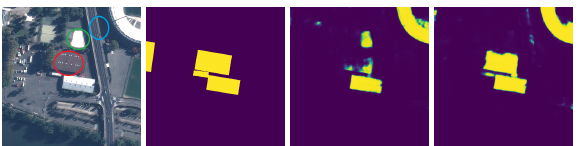
Figure 6. Advantage of stereo training for DispNetC network over an image of Toulouse (2). From left to right : image, ground truth, monocular prediction and stereo prediction